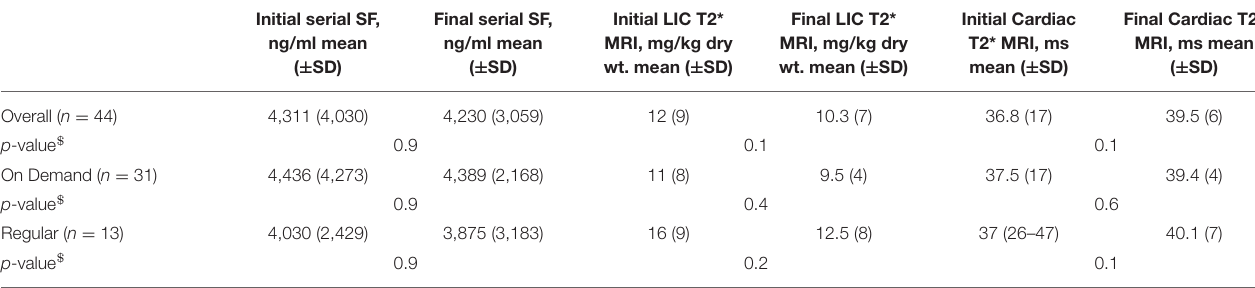
TABLE 2 | Effect of chelation: progressive change in iron burden with overall, on demand, and regular transfusion subgroups. Initial serial SF, ng/ml